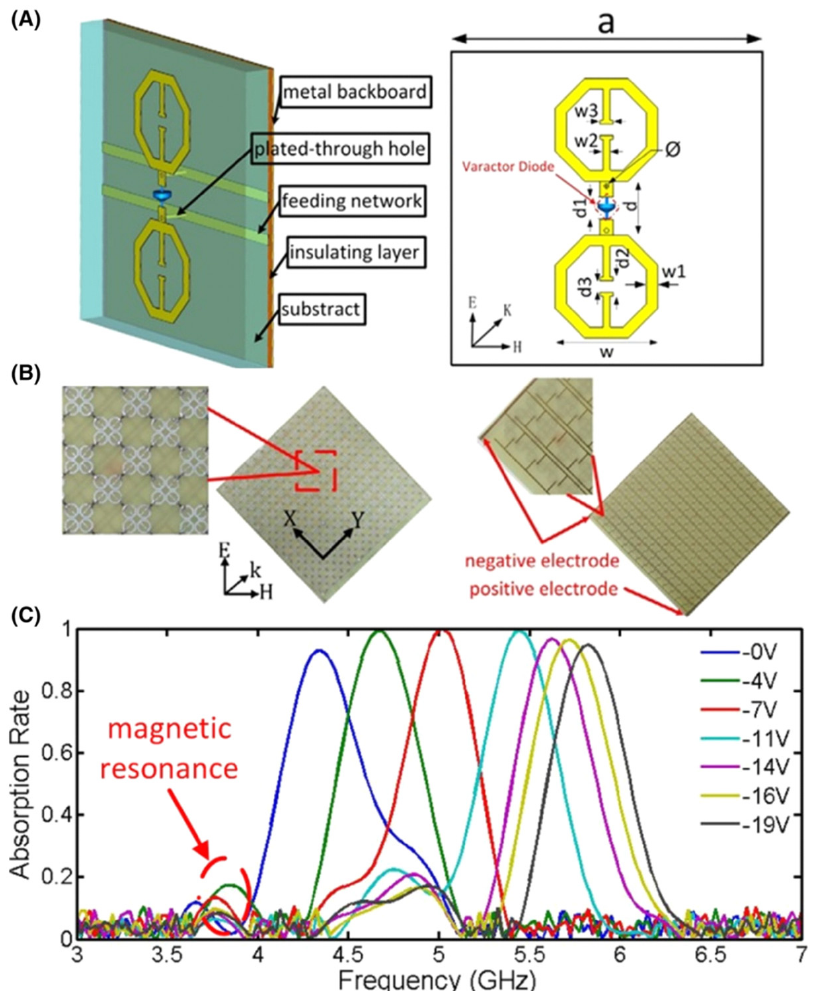
Figure 13. ( A ) Proposed metamaterial particle’s structure. ( B ) Fabricated sample front view and the varactor diodes feed network. ( C ) Absorption rates at different reverse bias voltages from 0 to 19 V. (Reprinted under the Creative Commons Attribution 3.0 license).